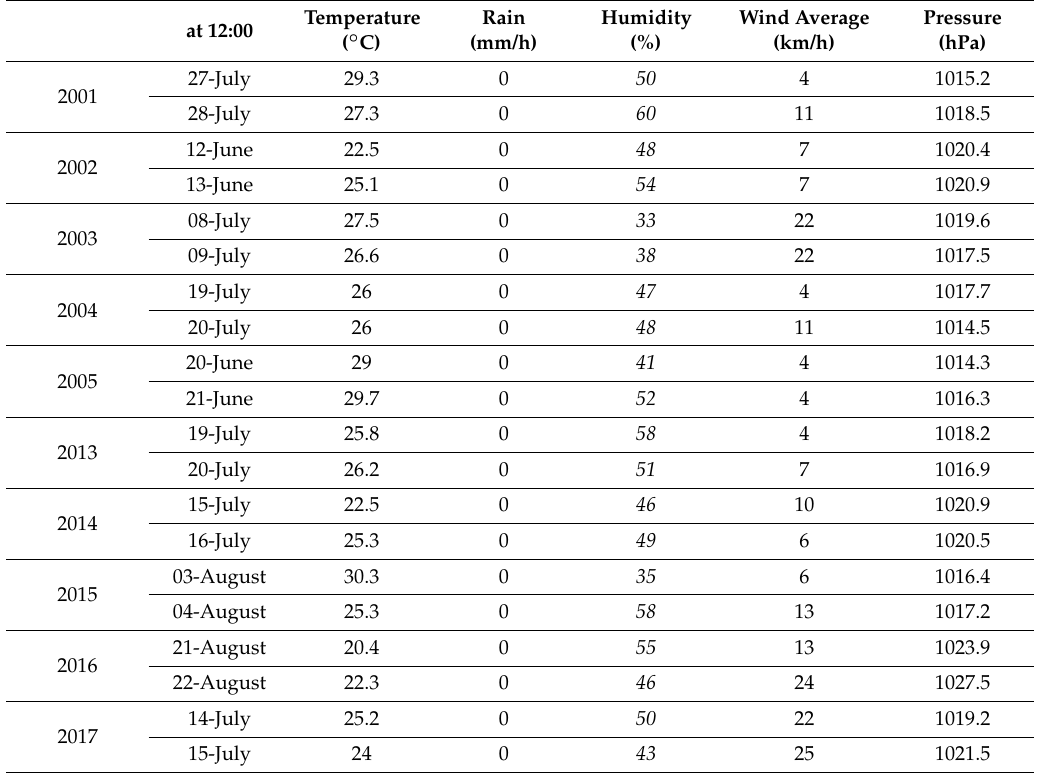
Table 2. Meteorological parameters of the two previous study days at the Lyon-Bron station at 12:00 (source: M é t é